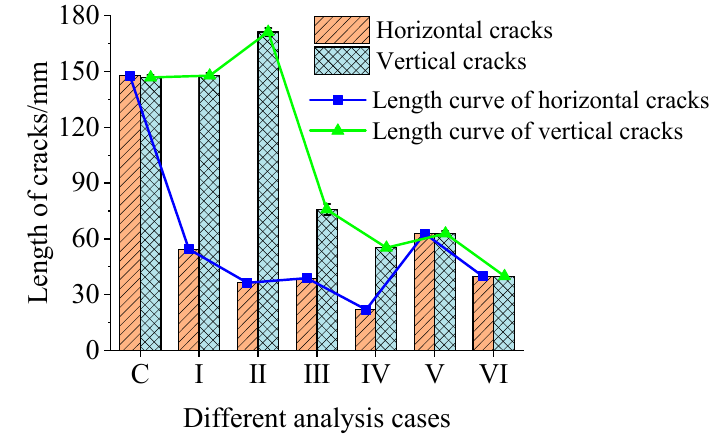
Figure 11. Crack length under different in ‐ situ stresses.